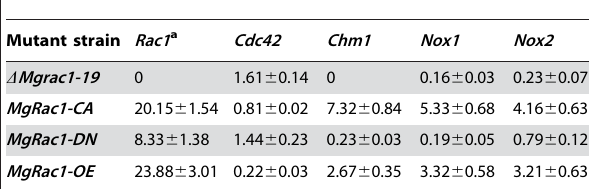
a Relative quantity of the indicated transcripts in the mutant strains, relative to that in the wild-type strain 70-15. A value of greater than 1 indicates increased expression, while a value of smaller than 1 indicates decreased expression. Mean and standard deviation were calculated with the data from three replicates.